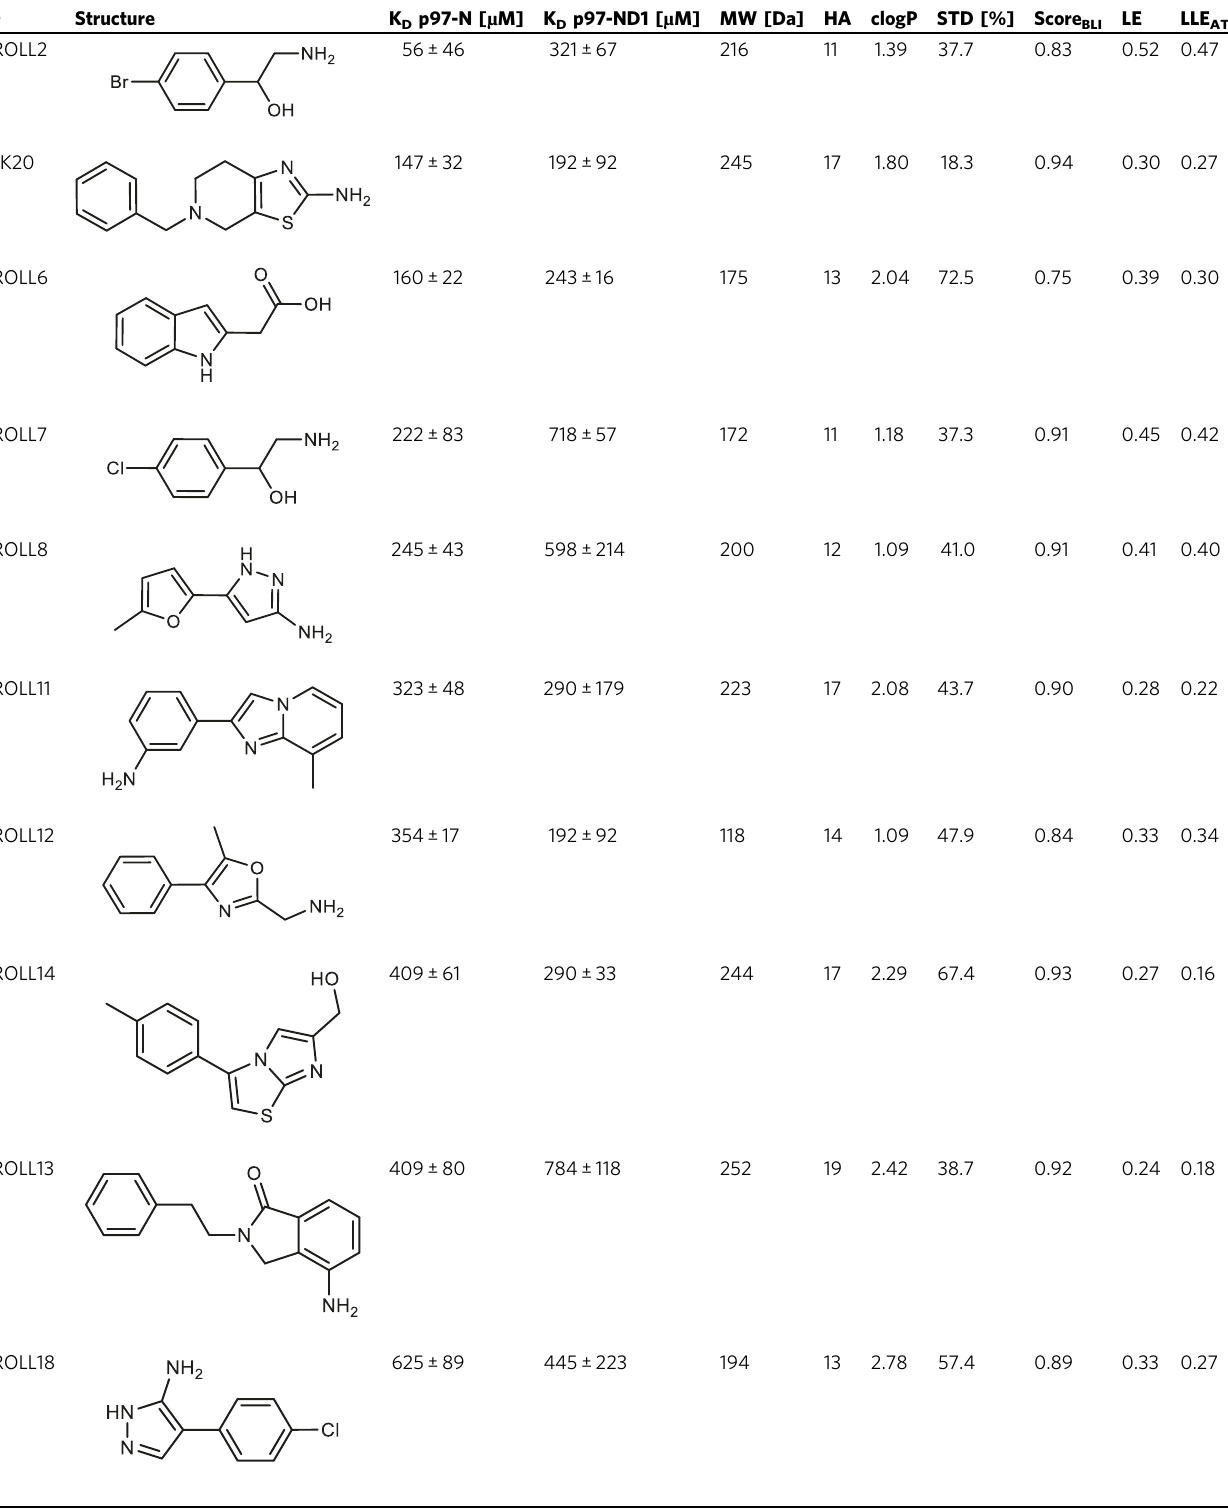
Table 1 Overview of the identi fi ed fragments binding to the N-domain of